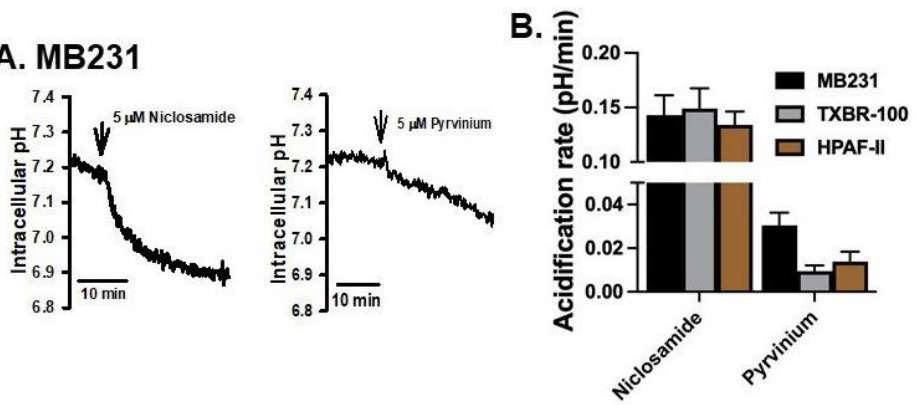
Figure 2. Comparison of the effects on intracellular acidification between niclosamide and pyrvinium. The time course of cellular acidification is shown in ( A ) for MB231 cells. The experiment was repeated for two additional cell lines (TXBR-100 and HPAF-II), and the magnitude of acidification for all three cell lines are shown (means ± S.E.M.) ( B ).